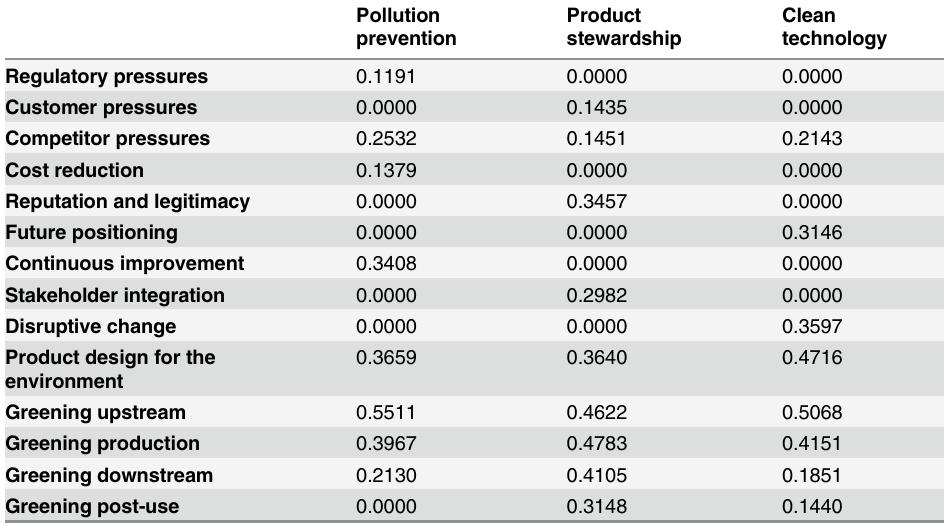
Table 7. The total effect of the elements on the target variable